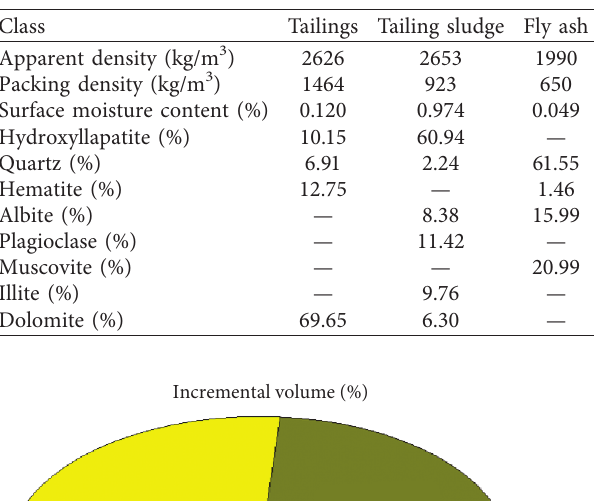
Table 1: Physical properties of the materials.